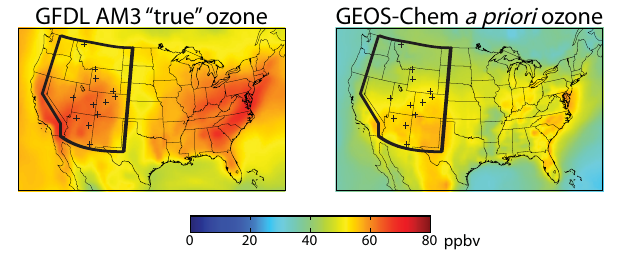
Figure 1. Mean values of the daily maximum 8h average (MDA8) ozone concentrations for April–June 2010 in surface air. Left panel shows values from the GFDL AM3 CCM used as the “true” atmo- sphere in our OSSE. Right panel shows the a priori values from the GEOS-Chem CTM used for data assimilation. Red/blue col- oring denotes relatively high/low ozone values respectively. The black lines delineate the Intermountain West and black crosses show CASTNet surface measurement sites in the